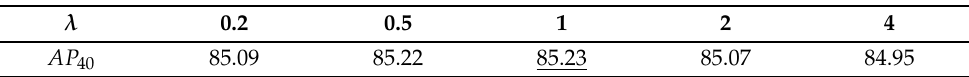
Table 7. The selection weights for auxiliary tasks on car moderate . λ means the weight of the auxiliary tasks to the main task. The best results are underlined.